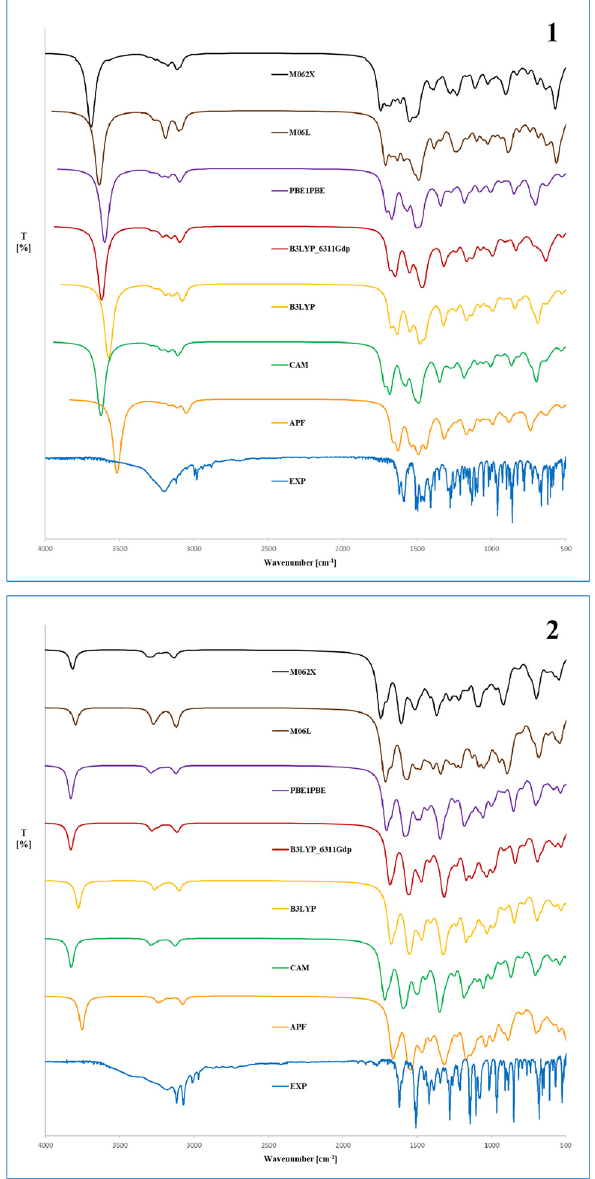
Figure 3: Expended experimental ( EXP ) and theoretical IR spectra ( DFT formalism, gaseous phase ) of voriconazole ( 1 ) or fl uconazole